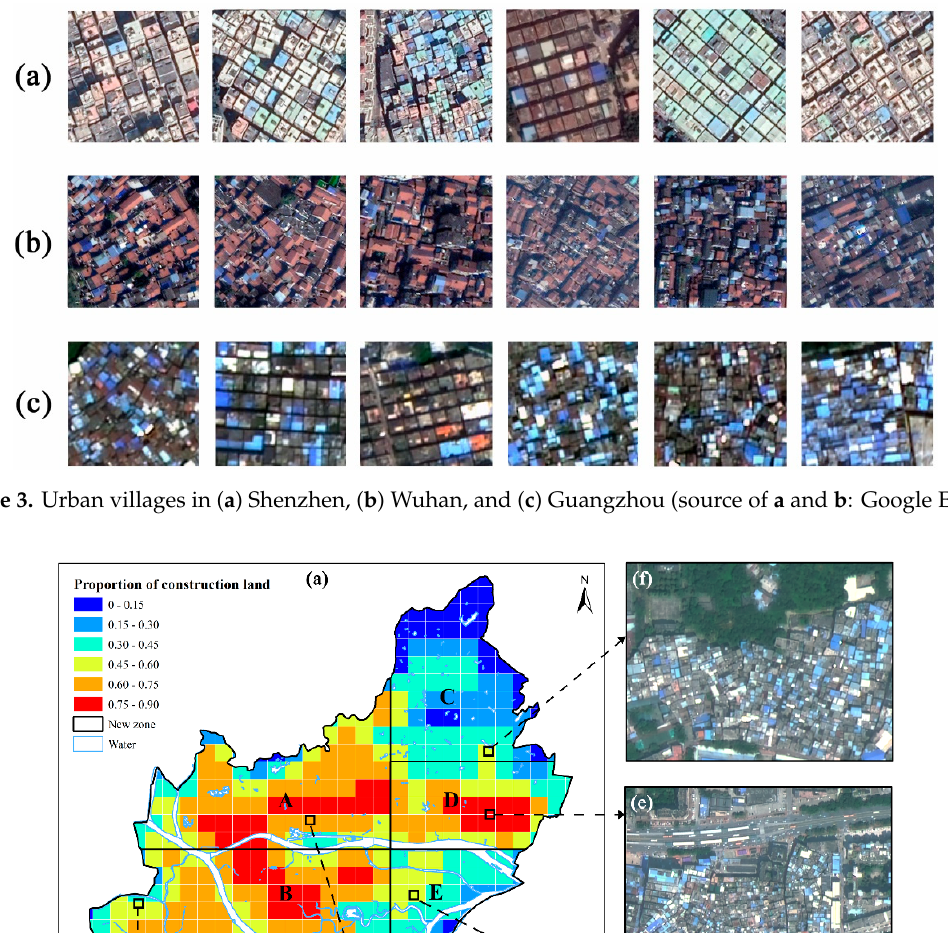
Figure 3. Urban villages in ( a ) Shenzhen, ( b ) Wuhan, and ( c ) Guangzhou (source of a and b : Google Earth).